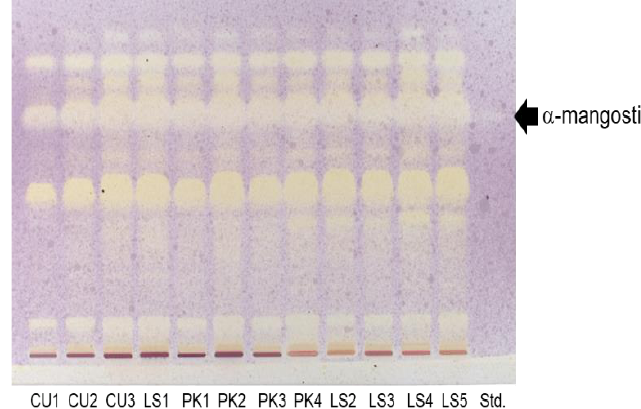
Figure 7: Phytochemical fingerprint of the mangosteen pericarp methanol extracts and the reaction to DPPH on TLC plate. CU1, CU2, and CU3 are mangosteen pericarp samples collected from Cha-Uat, LS1, LS2, LS3, LS4, and LS5 are the mangosteen pericarp from Lanska, PK1, PK2, PK3, and PK4 are the mangosteen pericarp from Prom Kiri. The Std. is alpha-mangostin authentic standard and arrow indicated for the position of the alpha-mangostin.